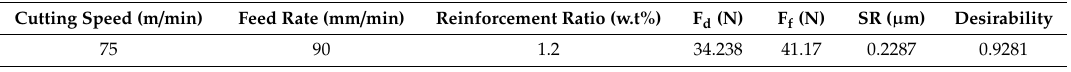
Table 12. Optimal milling parameters and GNPs reinforcement ratio obtained by desirability approach.